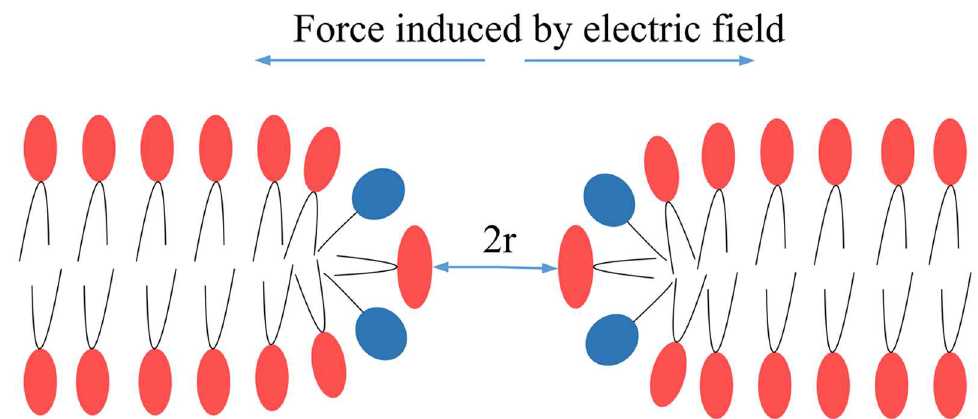
Fig 11. Schematic demonstrating that the force induced by the electric field contributes to the development of electroporation; r is the pore radius.